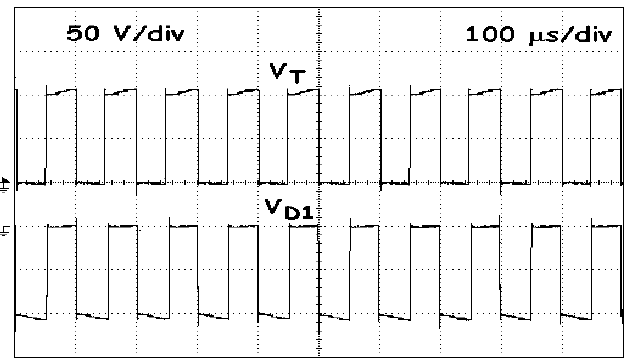
Figure 19. Experimental results for the voltage across the diodes D 2 and D 3 in buck mode.